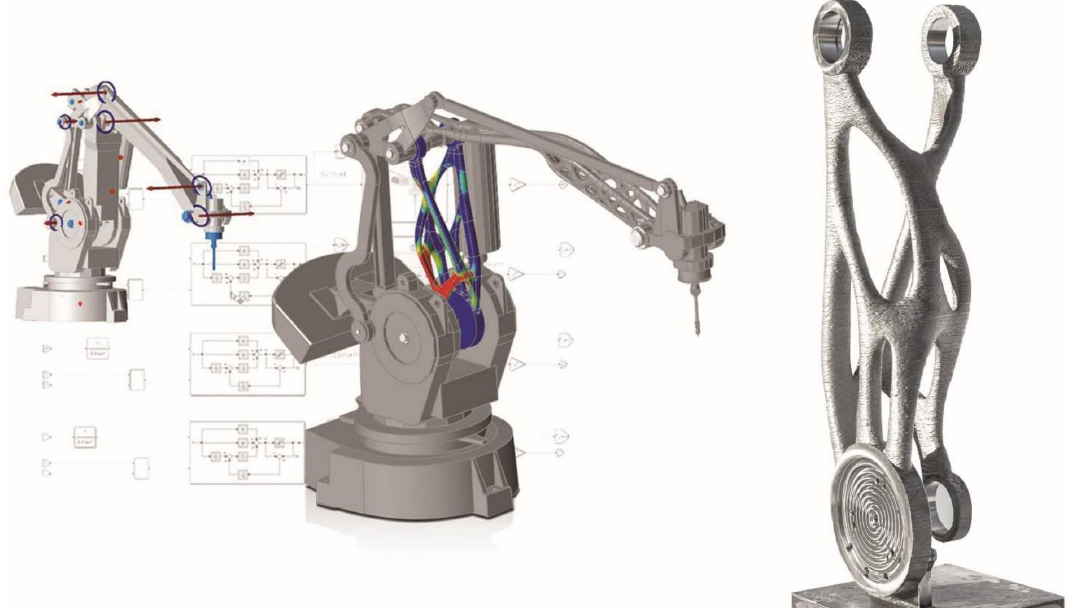
Figure 7. An illustration of DT in robotics: in a joint project MX3D, ABB, and Altair demonstrated how a 3D-printed robot can be improved by using a digital twin process to achieve more precise positioning [259]. ©Altair. Table 4. Summary of AI-enabled DTs in advanced robotics.